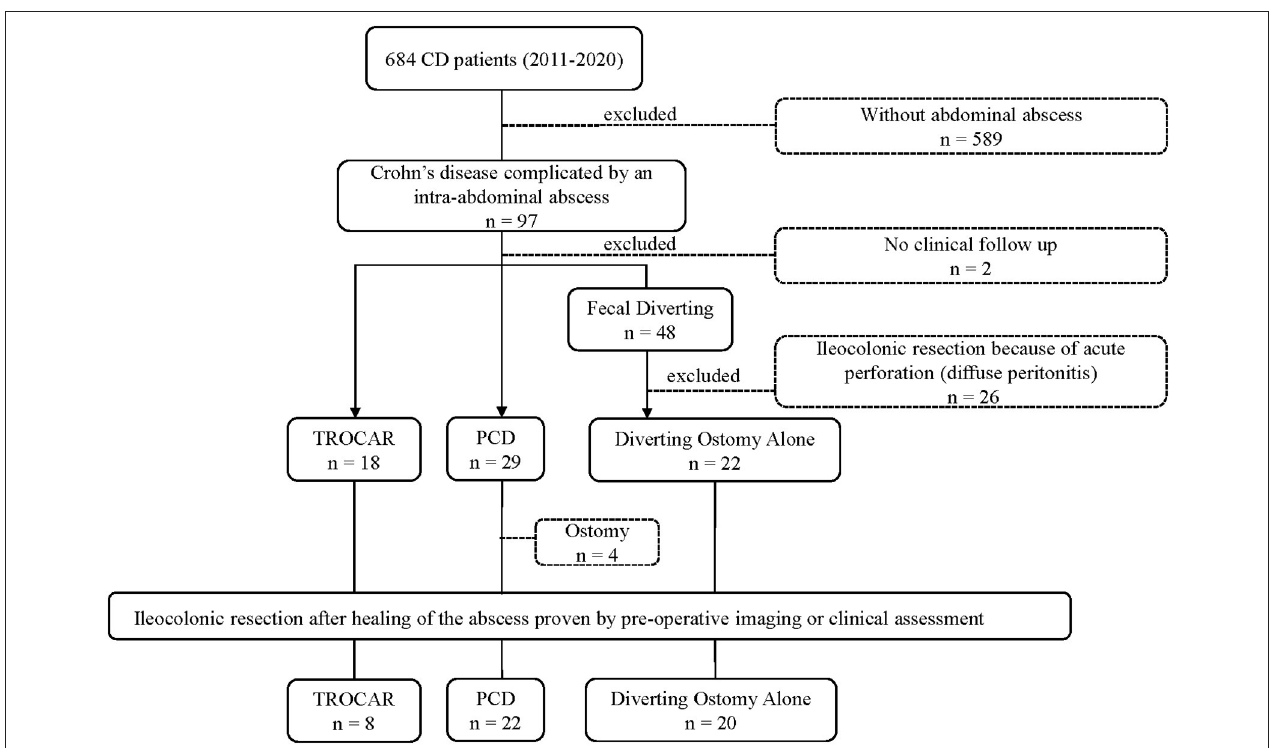
FIGURE 2 | Flowchart of enrolled patients of all patients with Crohn’s disease (CD) between October 2011 and December 2020 in the general surgery department of Jinling